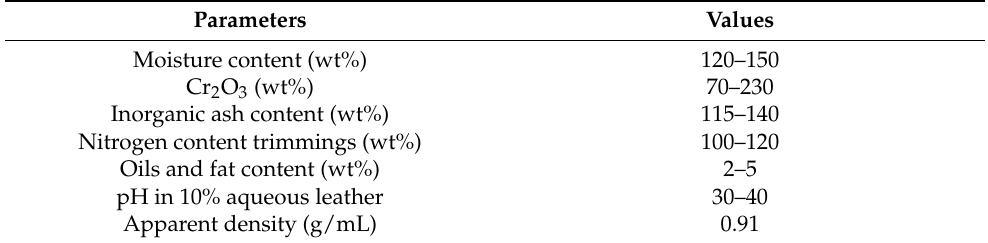
Table 3. Physical characteristic and composition of chrome-tanned leather shavings (CTLSs).